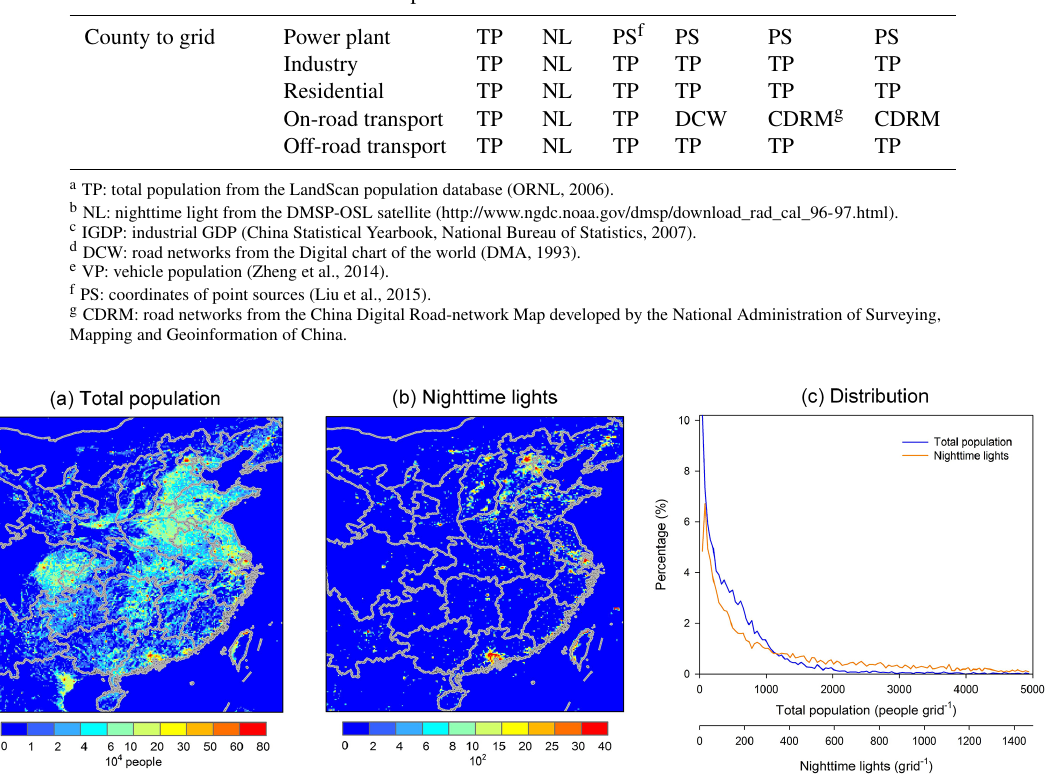
Figure 1. Spatial patterns of (a) the total population density and (b) nighttime lights for eastern China and (c) the distributions of total population density and nighttime lights in China at a resolution of 0.1 ◦ × 0.1 ◦